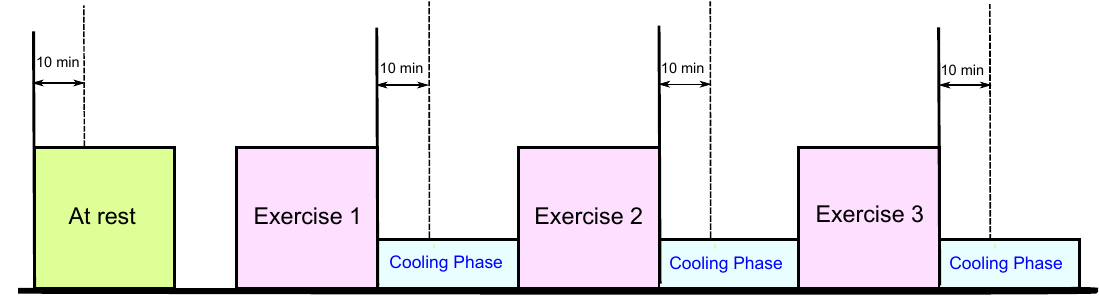
Figure 2. Measurement protocol. The duration of the whole experiment was approximately 4 h; each exercise consumed approximately 30 min, while the photoplethysmogram (PPG) signals were collected during the 30-min break of each